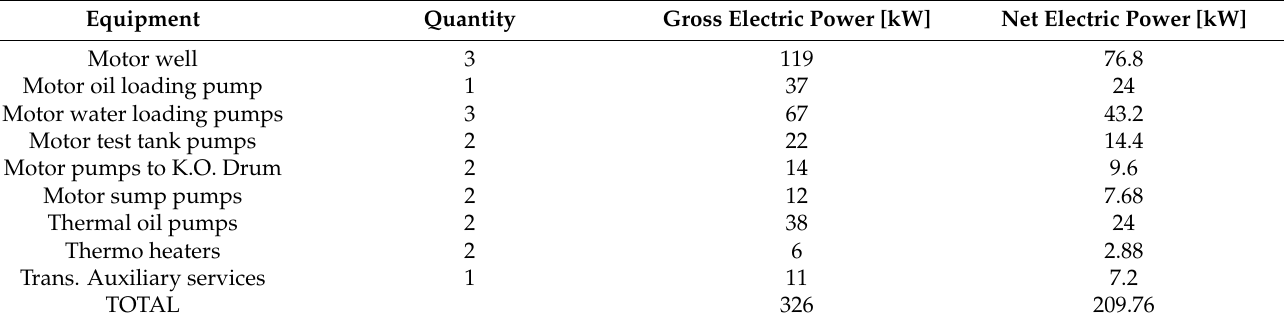
Table 2. Energy consumption on a base model petroleum